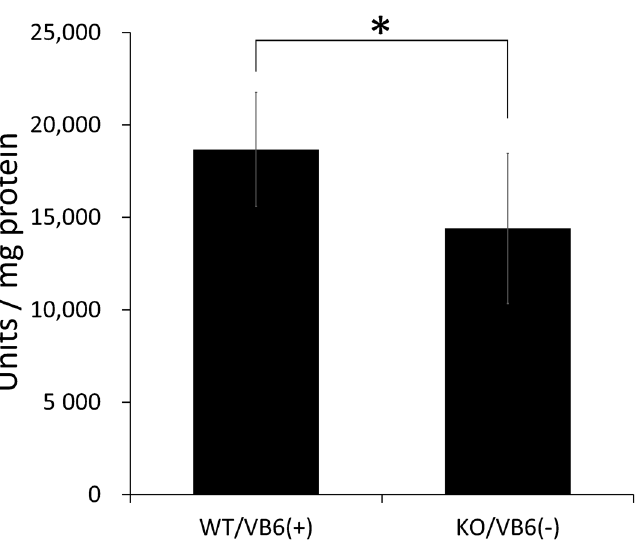
Figure 6. Creatine kinase activity in mouse hippocampus homogenates. CK activity (U/mg) was assayed using hippocampal homogenates (20 g) of WT/VB6(+) mice or KO/VB6( − ) mice. Values are presented as mean ± SD ( n = 8). Error bars represent SD. * p < 0.05.